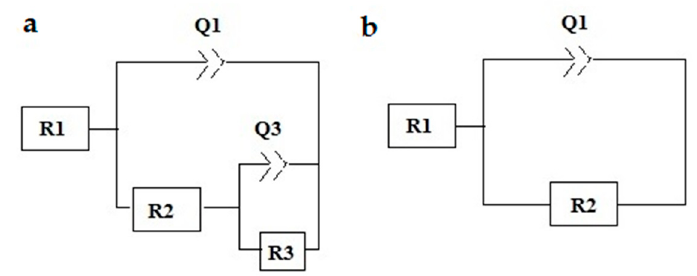
Figure 7. Equivalent electric circuits used to simulate the EIS results for the and CER3 ( a ) RP and CER1 ( b ).